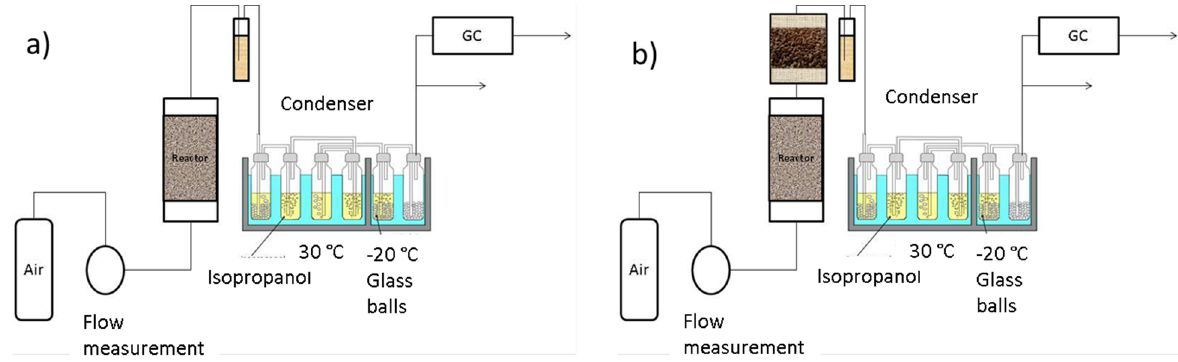
Figure 1. Laboratory scale gasification unit: ( a ) without secondary catalysis ( b ) with secondary